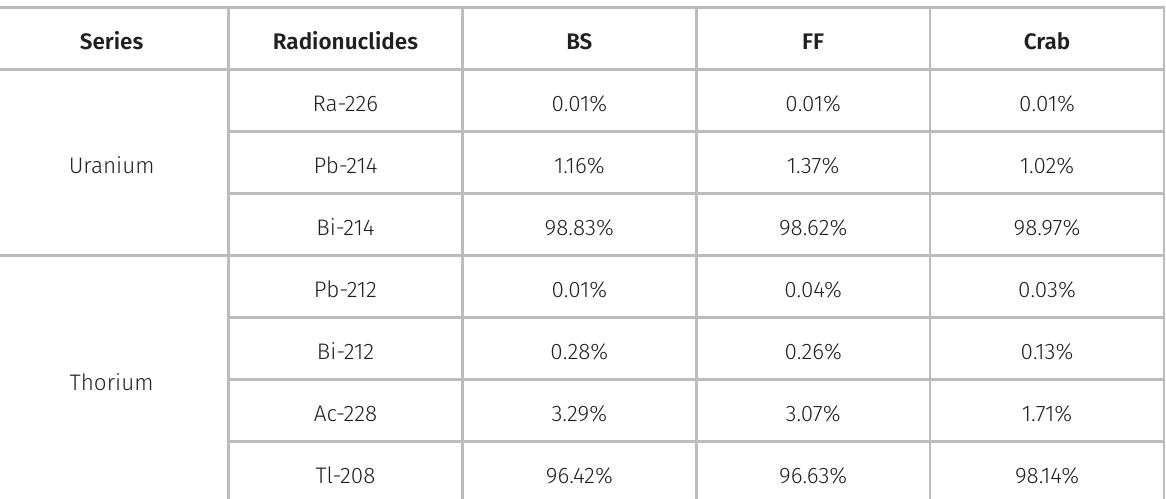
Table IV. Percentage of D